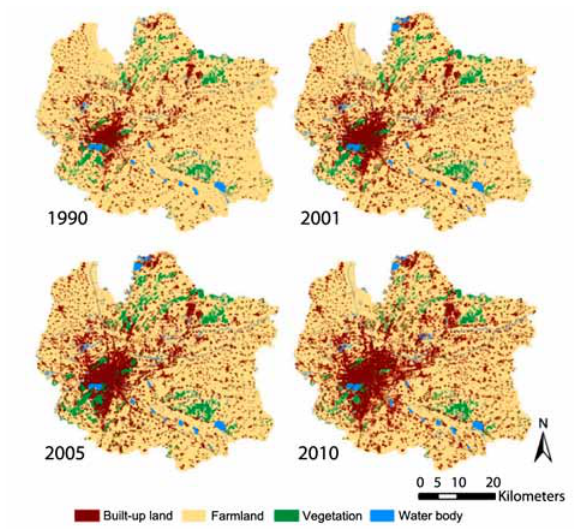
Fig. 2. Classified land cover maps of Xuzhou city from 1990